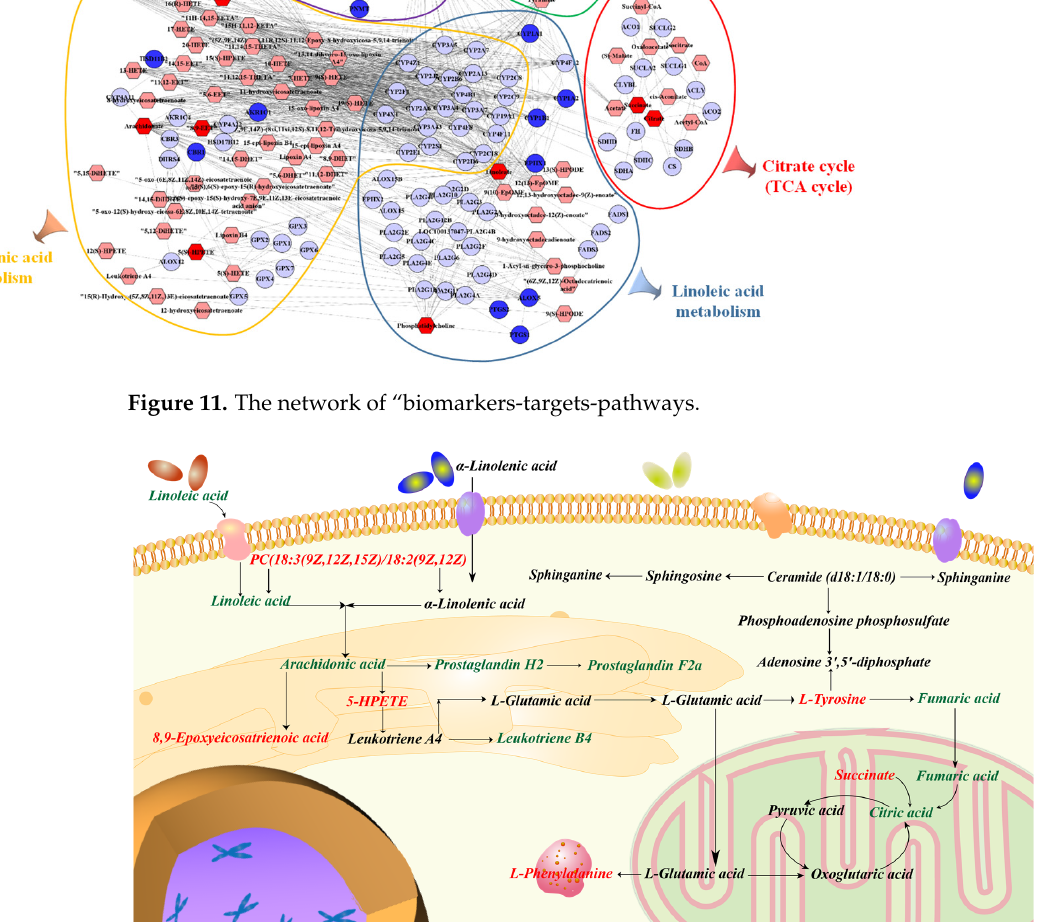
Figure 12. Metabolic network including key biomarkers and their metabolic